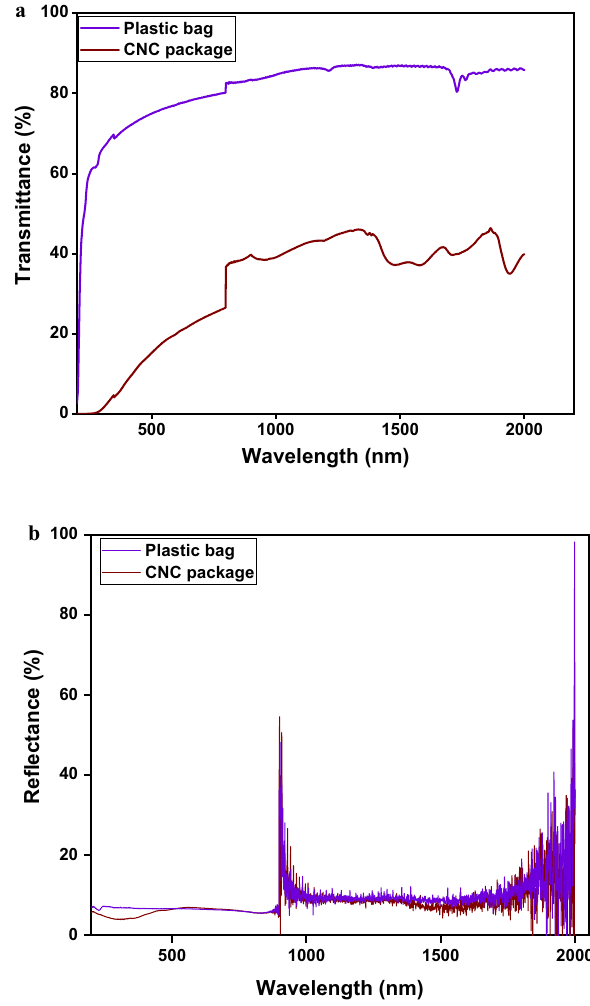
Figure 5. Light transmittance ( a ) and reflectance ( b ) spectra of plastic bag and CNCs package.